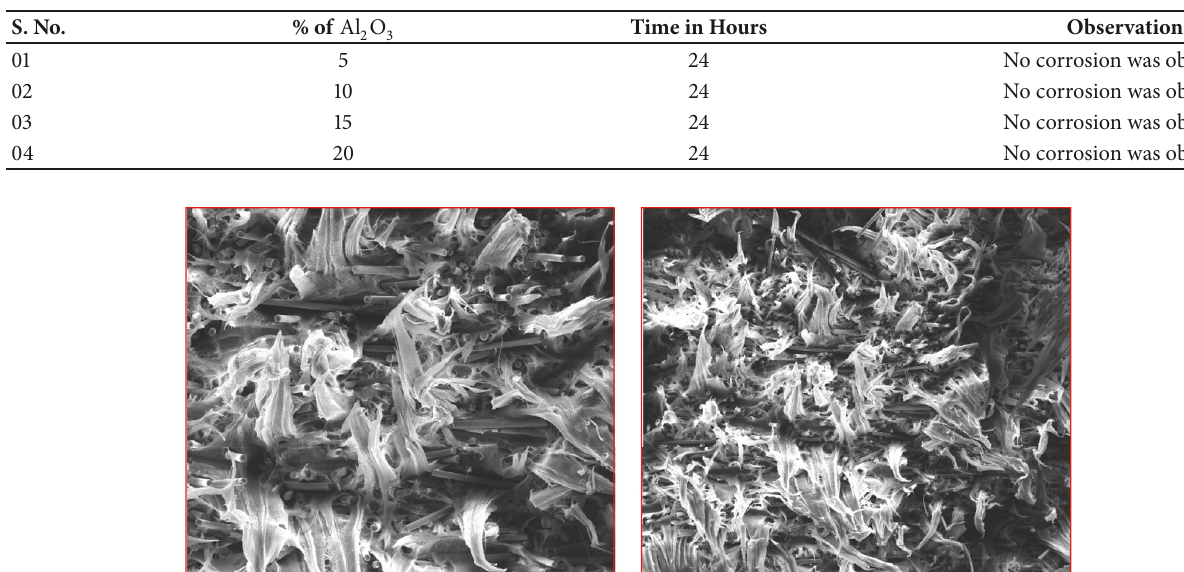
Table 3: Corrosion test results.